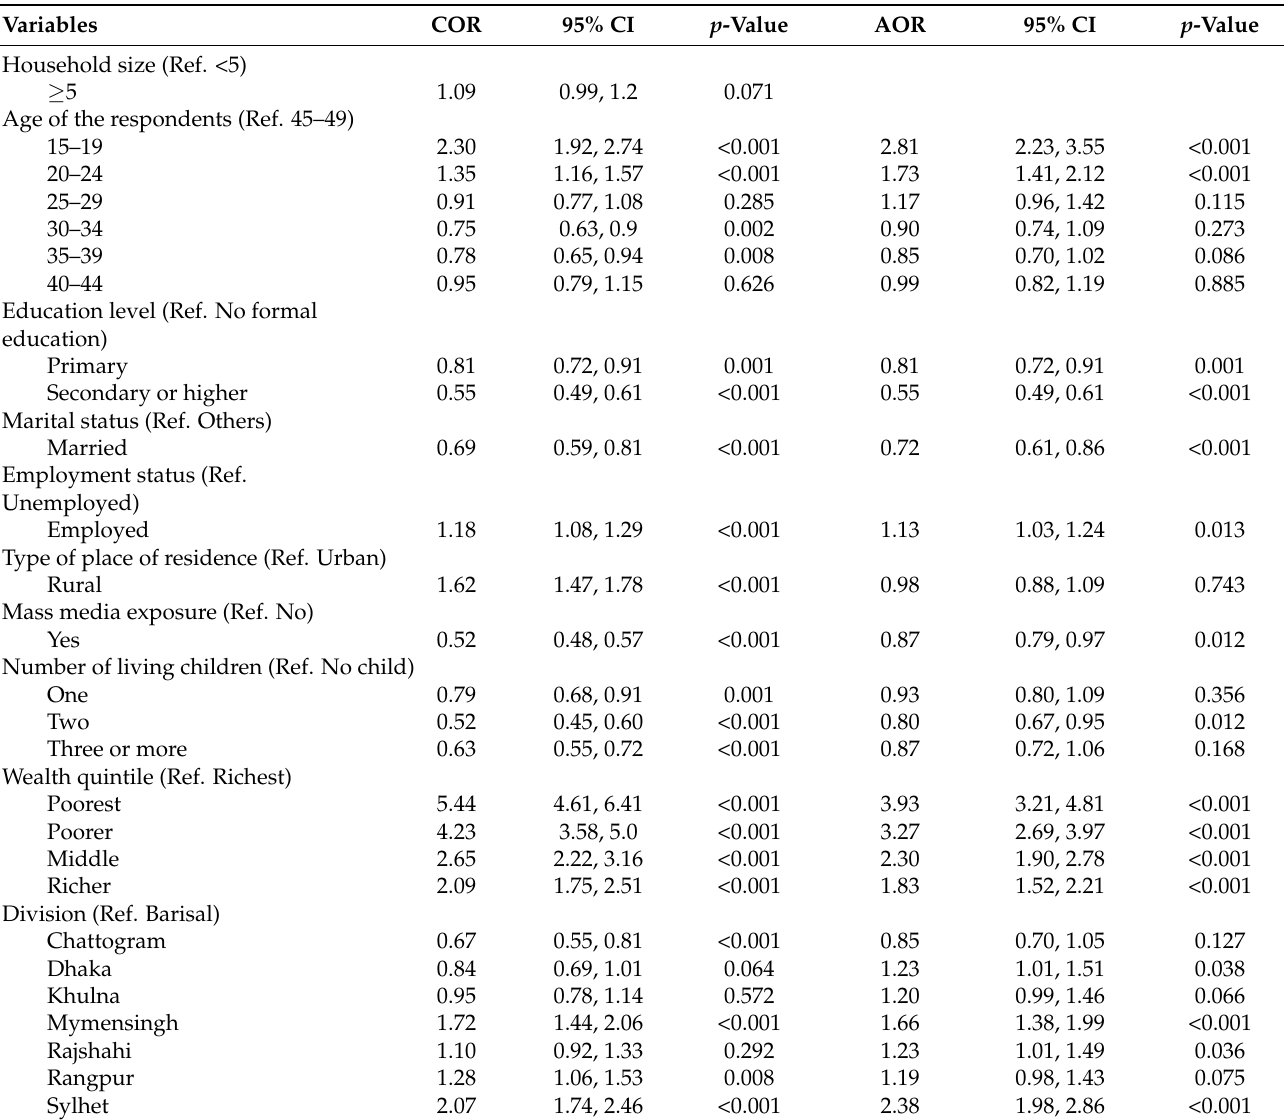
Table 2. Factors associated with undernutrition among women of reproductive